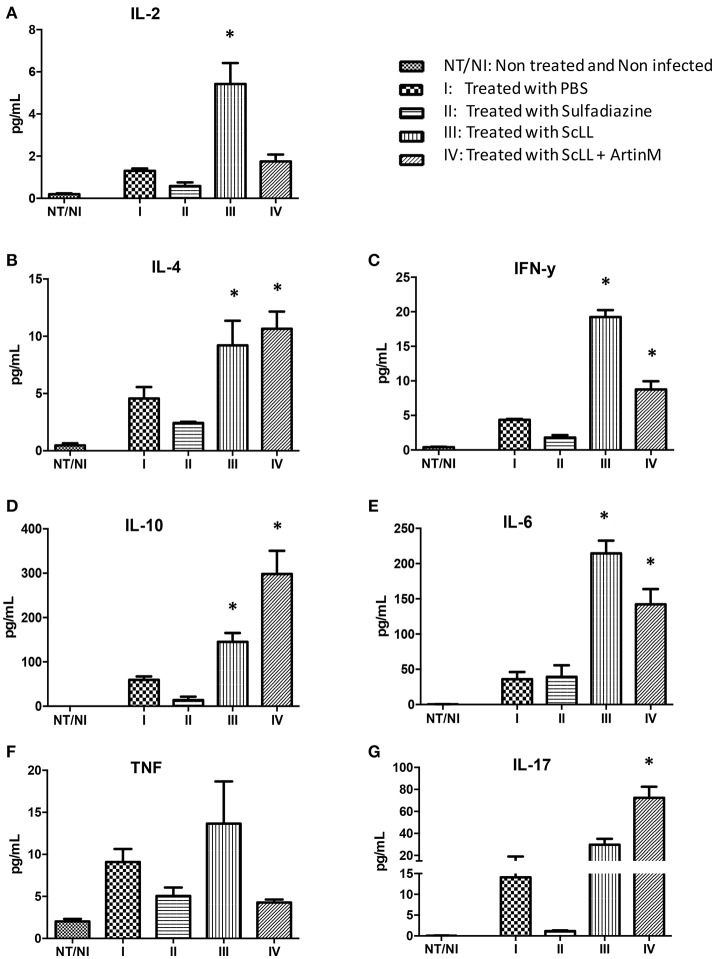
Effects of sulfadiazine and lectin treatments in the levels of IL-2 (A), IL-4 (B), IFN-γ (C), IL-10 (D), IL-6 (E), TNF (F), and IL-17 (G) cytokines in serum samples from C57BL/6 mice. Results are expressed as mean ± SD of the cytokine levels in pg/mL. Statistically significances were determined by comparison of the values obtained in the infected and treated groups with non-treated and non-infected mice. Statistical test was performed using One-way ANOVA and Tukey's multiple comparison post-test. *Indicates significant differences (P < 0.05).